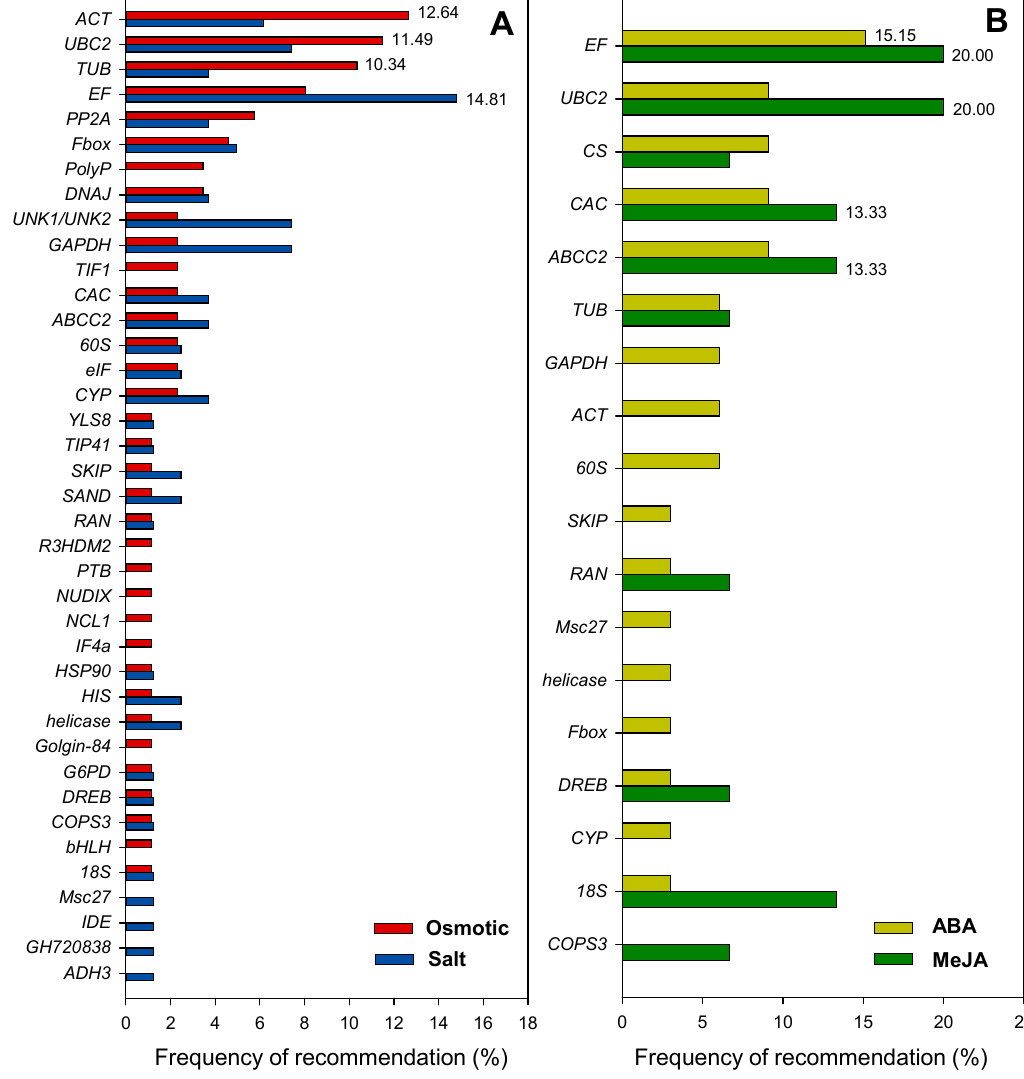
Figure 7. Frequency of reference genes recommended for qRT-PCR analysis under different experimental conditions in Leguminosae plants: here, we surveyed the frequency of each reference gene recommended for abiotic (osmotic/drought and salt) stresses ( A ) and hormonal (Abscisic acid (ABA) and methyl jasmonic acid (MeJA)) treatments ( B ) among Leguminosae species. The top three reference genes recommended for each species under different conditions are detailed in Table S5.